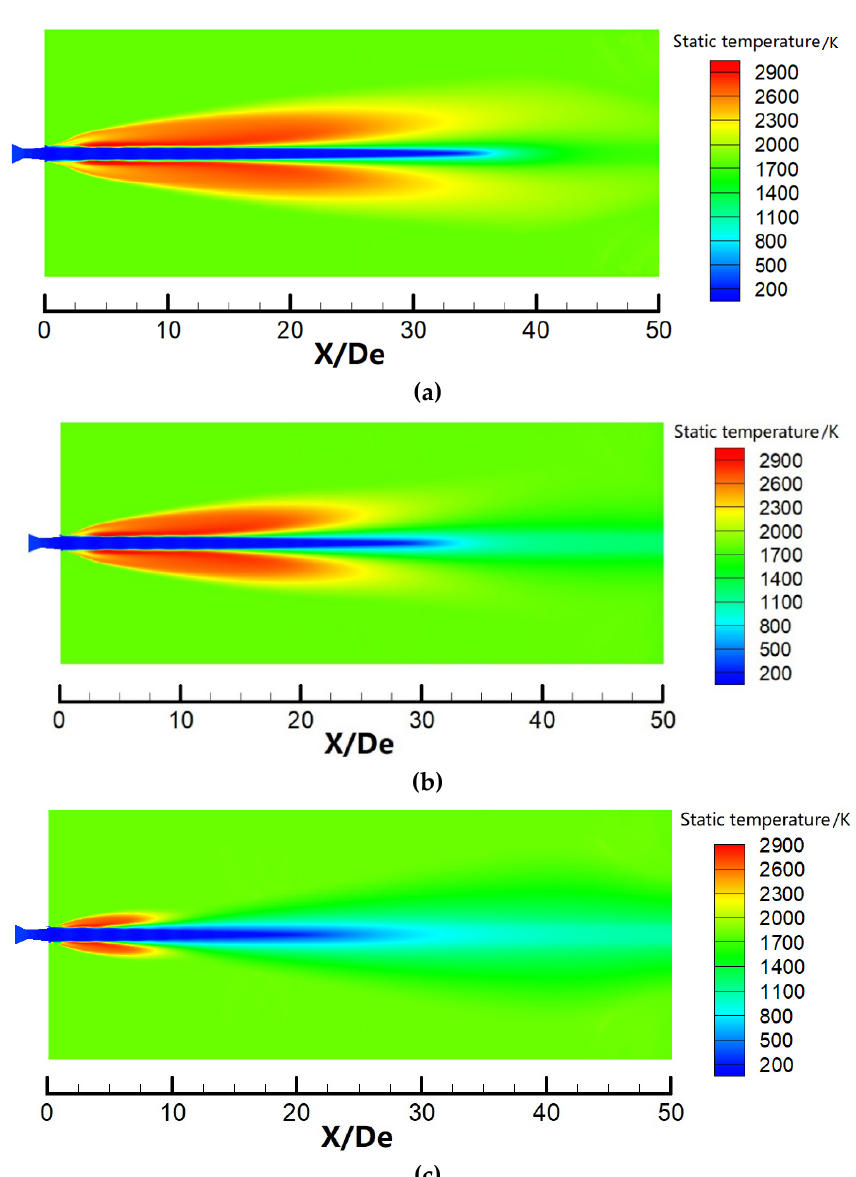
Figure 10. Static temperature contours for three jets: ( a ) methane: nitrogen ratio (RMN) = 10:0; ( b ) RMN = 8:2; and ( c ) RMN = 4:6.